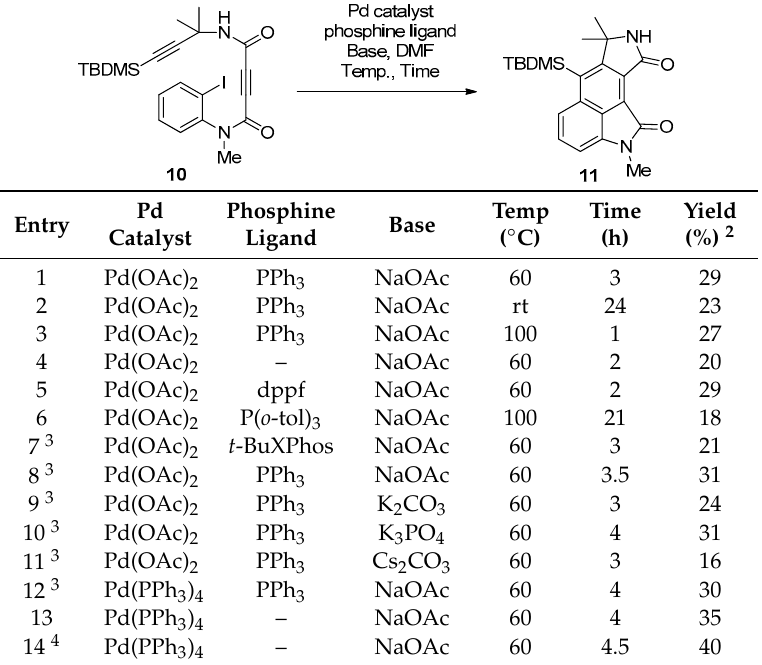
Table 1. Optimization of domino cyclization reaction of 10 1 .